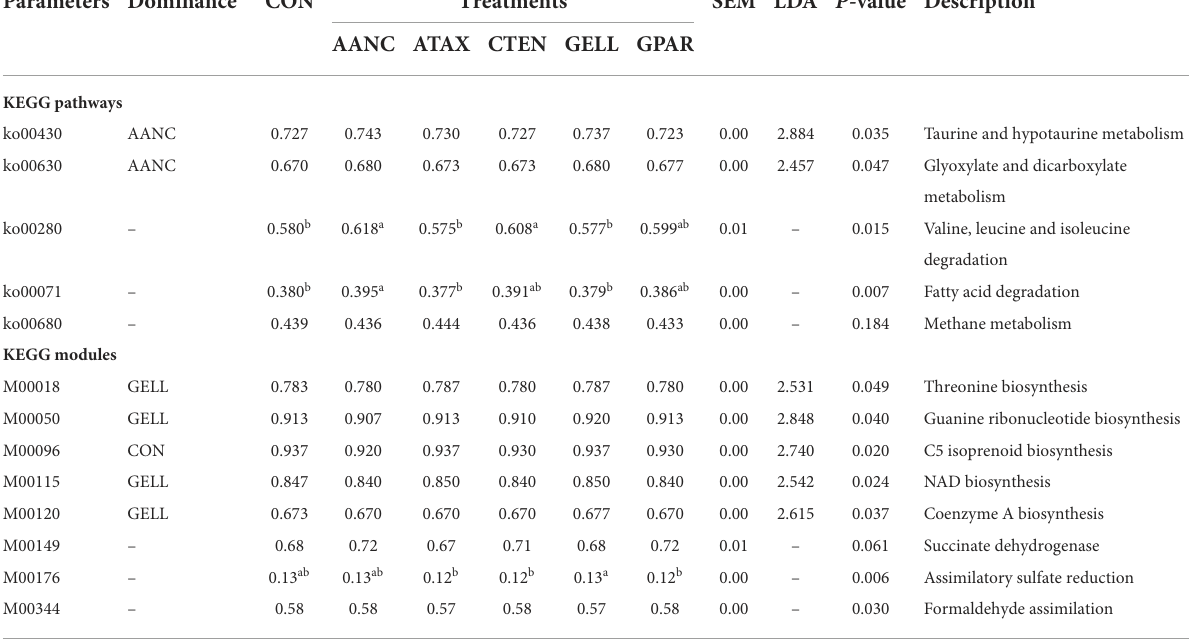
TABLE 5 Abundance of KEGG pathways and modules in response to supplementation with red seaweed extracts evaluated with LEfSe analysis after 24h of in vitro incubation. Parameters Dominance 1